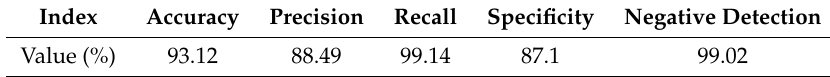
Table 20. Forecast indices value.